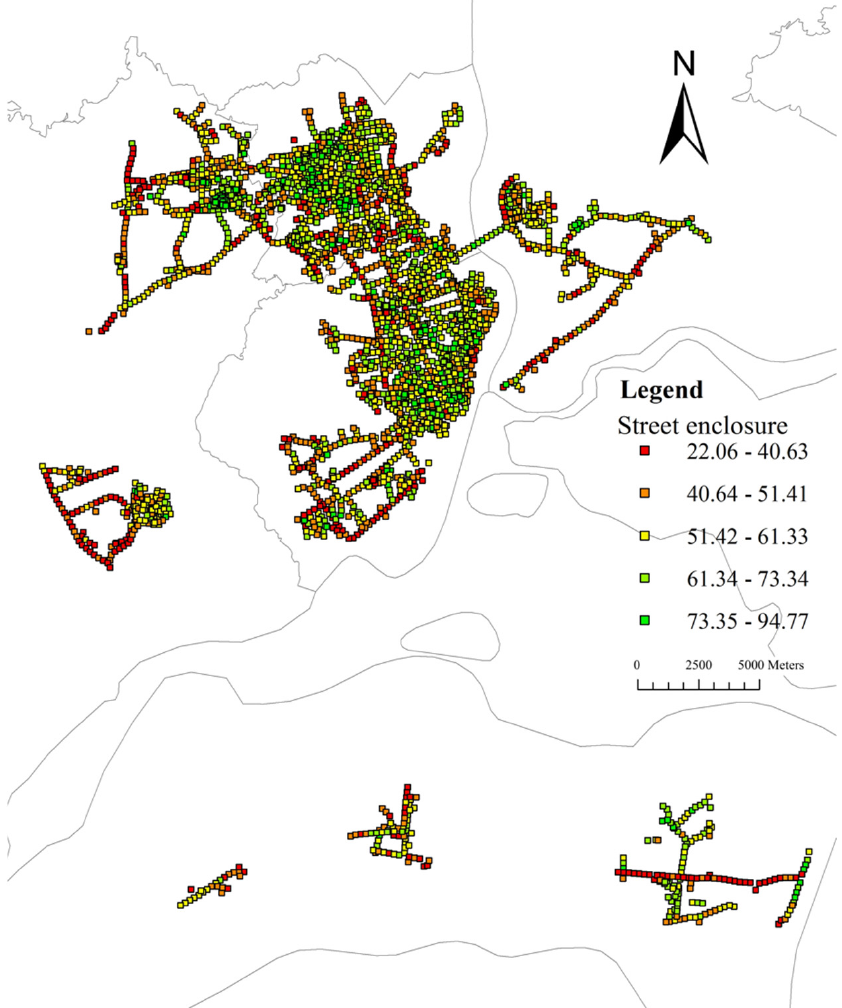
Figure 10. Street enclosure spatial distribution map.